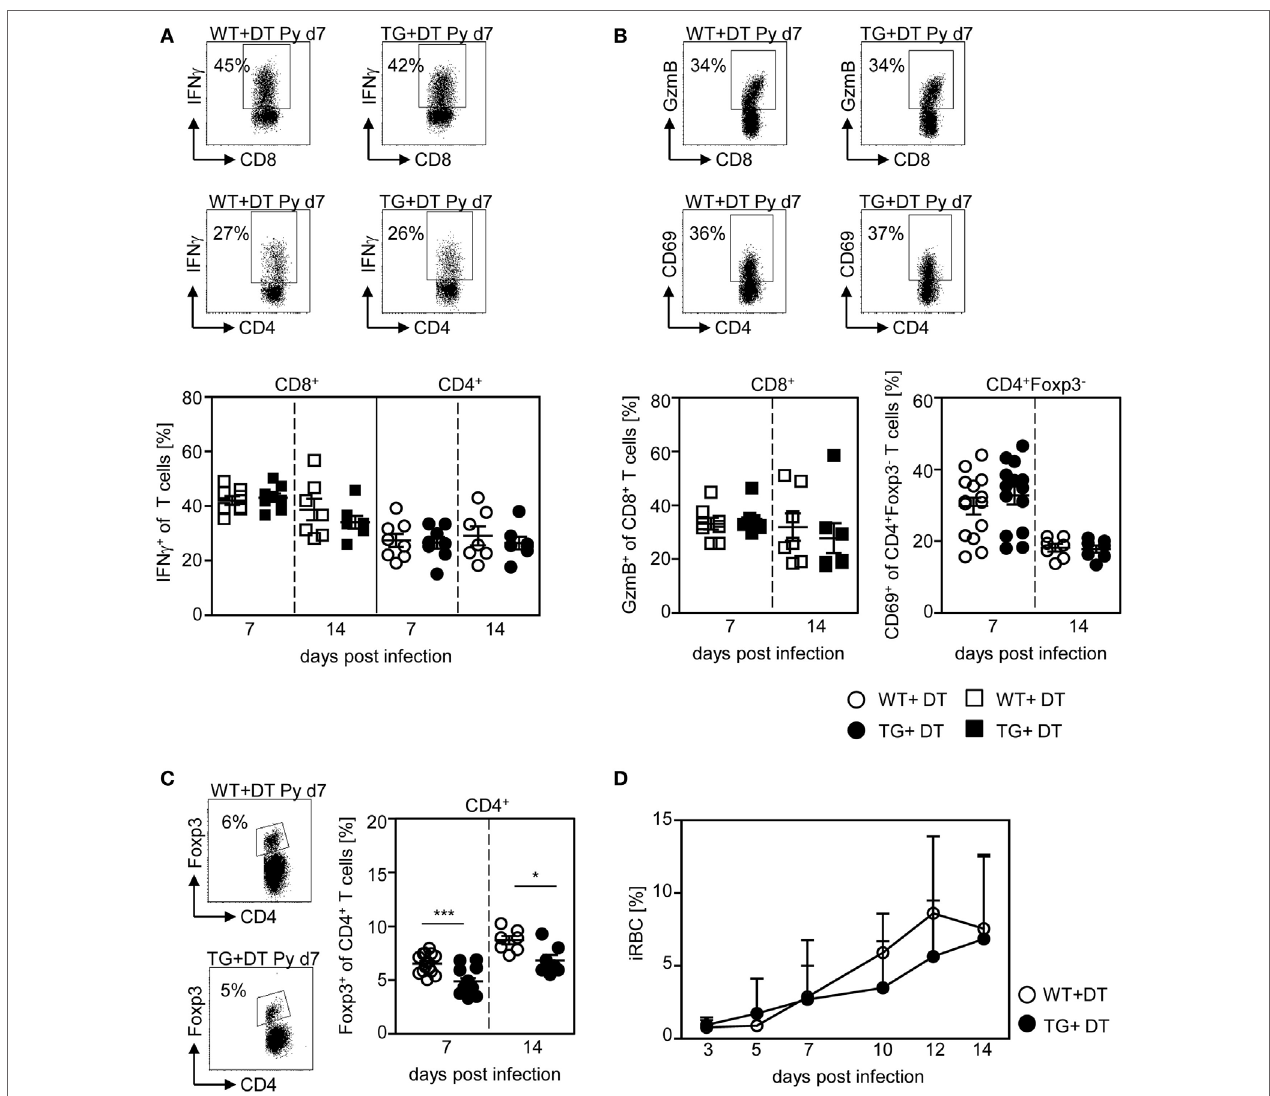
FigUre 6 | CD11c high dendritic cell depletion at later time points has no impact on T cell activation and parasite burden. RosaiDTR/CD11c-cre (TG) and RosaiDTR wild-type (WT) mice were infected with Plasmodium yoelii and treated daily with DT ( + DT) starting at day 4 post infection. At day 7 and day 14 post infection splenocytes were isolated. The percentage of (a) IFN- γ producing CD8 + and CD4 + T cells, (B) GzmB-expressing CD8 + T cells and CD69-expressing CD4 + Foxp3 − T cells as well as (c) the percentage of Foxp3 + CD4 + regulatory T cells (Tregs) were determined by flow cytometry. Representative dot plots are shown in the upper panels. Results from two to four independent experiments with n = 7–14 mice per time point were summarized as mean ± SEM. (D) Parasitemia was determined at days 3, 5, 7, 10, 12, and 14 post infection by Giemsa-staining and results from two to four independent experiments with n = 23–24 mice in total are depicted as mean ± SEM. Statistical analysis was performed using the Student’s t -test and One-Way ANOVA (D) with * p < 0.05; *** p <